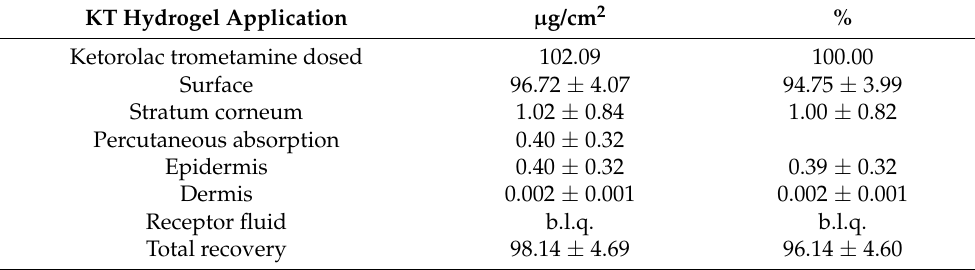
Table 3. Distribution of ketorolac within the skin layers 24 h after application of KT hydrogel under a finite-dose regimen. b.l.q. stands for ‘below limit of